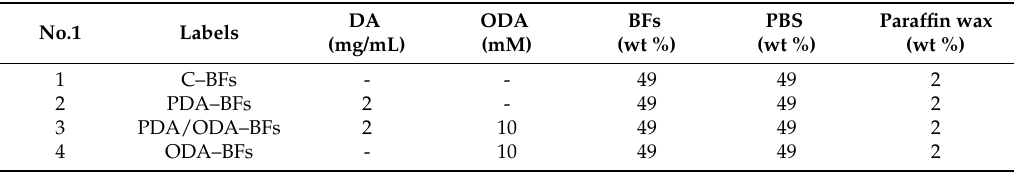
Table 1. Surface Modification of BFs and Formulations of Biocomposites under Different